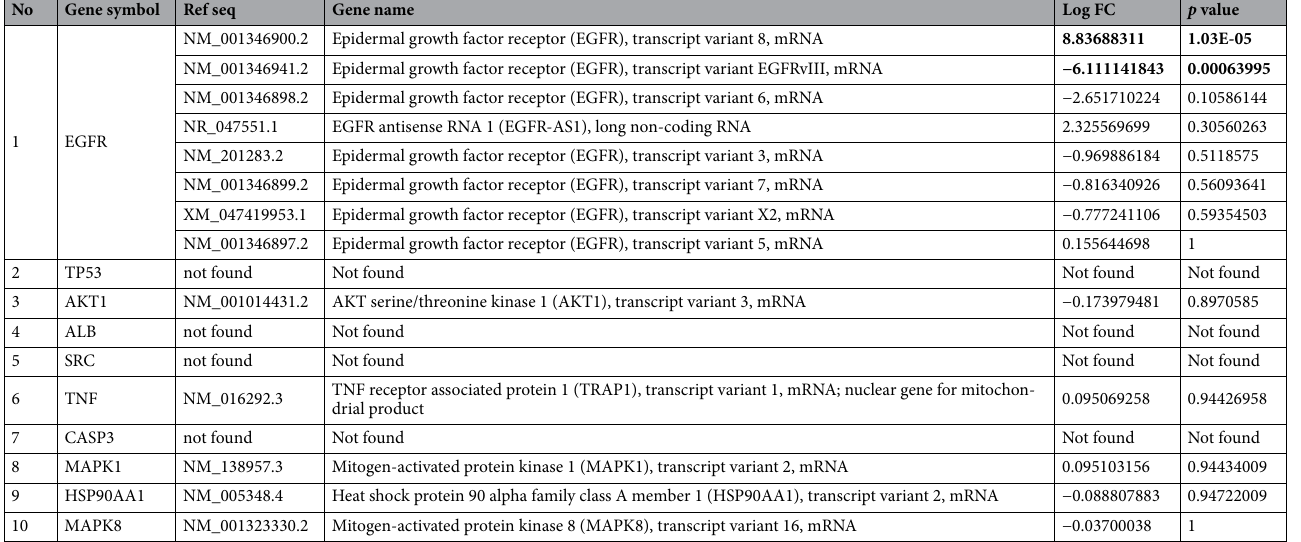
Table 4. Differentially expressed genes of hub genes in U87 glioblastoma cells upon treatment of CCA-1.1. Significant values are in